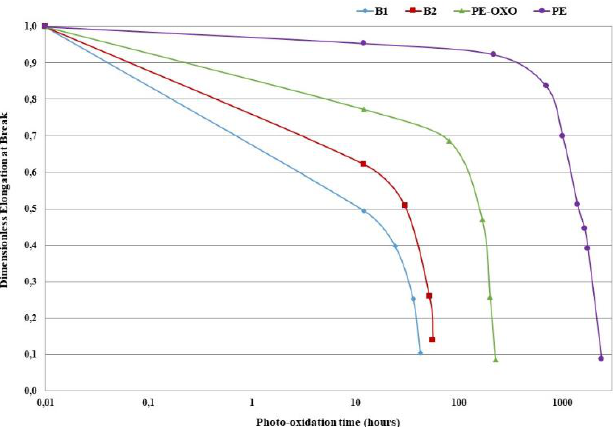
Figure 1. Dimensionless elongation at break vs. photo-oxidation time of all the samples.